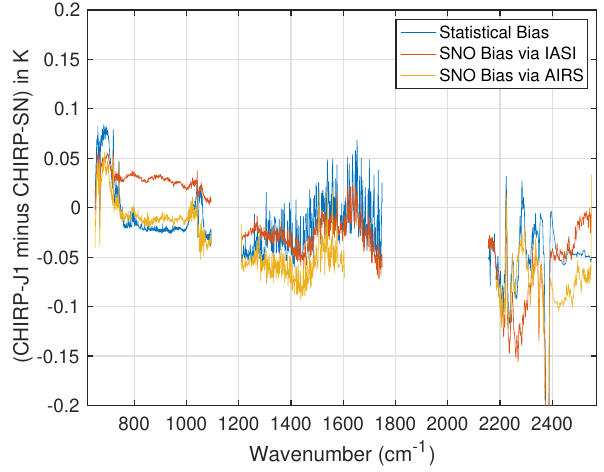
Figure 16. BT bias between NOAA20 and SNPP CrIS instruments, both converted to the CHIRP spectral response. These biases were derived from a 1-year 1 percent random subset of all NOAA20 and SNPP-CrIS radiances. Also shown are the SNO biases derived from either AIRS or IASI. Unlike Figure 8, these are double difference SNOs, ie SNO(NOAA20 − IASI) − SNO(SNPP − IASI) = SNO(NOAA20-SNPP), and similarly using AIRS as the SNO